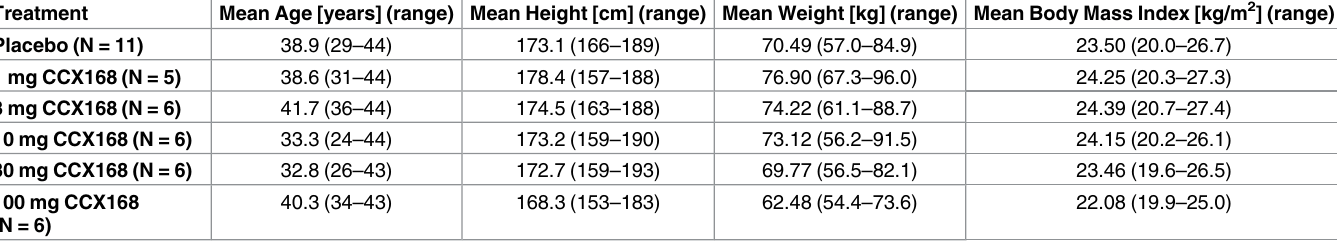
Table 1. Demographic Data for Subjects in Period 1 of the Phase 1 Clinical Study (Mean, Min—Max).